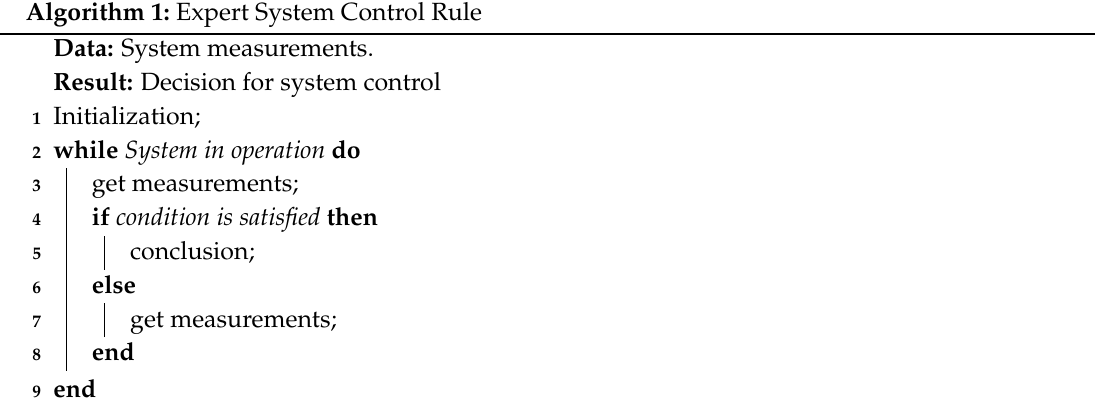
Algorithm 1: Expert System Control Rule Data: System measurements.